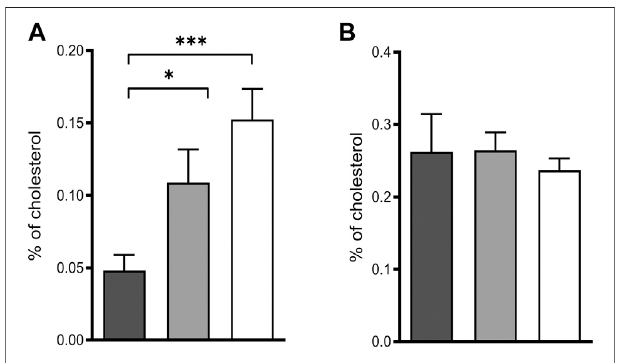
FIGURE 2 | Intermediates of cholesterol biosynthesis in HepaRG cells. Relative lanosterol (A) and lathosterol (B) concentrations as a percentage of cholesterol in HepaRG cells transduced with vector control (black) or sgRNAs POR#1 (light grey) and POR#2 (white) and differentiated for 2 weeks were analyzed by GC-MS. Shown are means and SD of four independent measurements. Statistical signi fi cance was assessed by one-way ANOVA with Bonferroni correction (* p < 0.05, ** p < 0.01, *** p < 0.001).